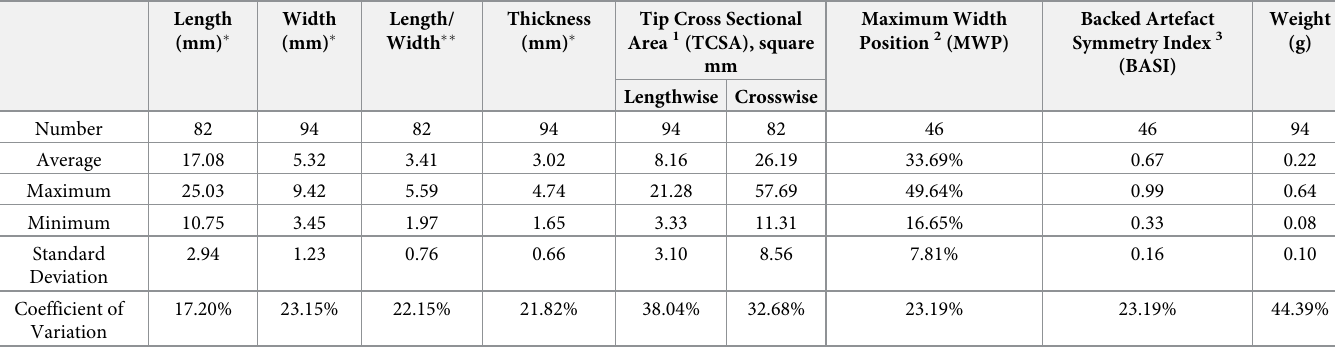
Table 9. Dimensions of chert and chalcedony finished microliths, Horizon IV, Saruq